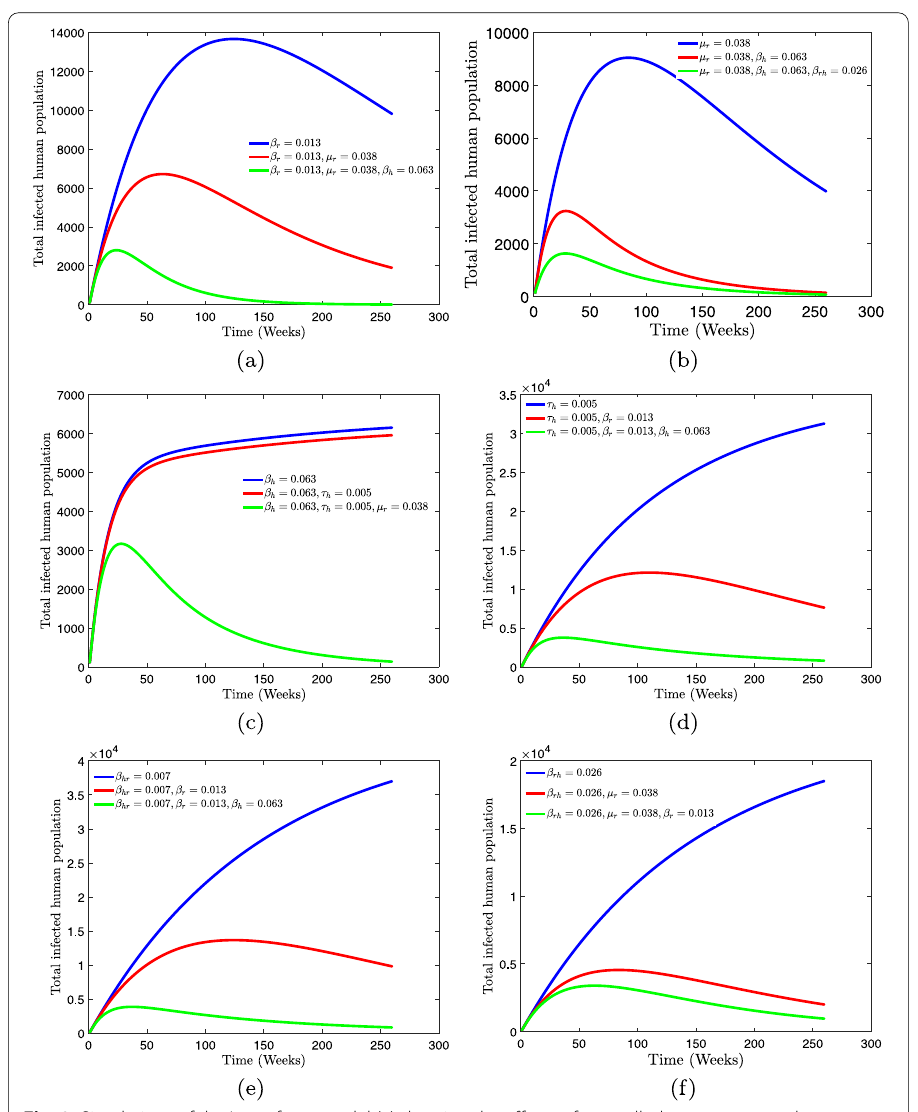
total infected human population ( E h + I h ) . The parameter values used are as given in Table 2 except for β h = 0.063 , β r = 0.013 , β hr = 0.007 , β rh = 0.026 , τ h = 0.005 , and µ r =